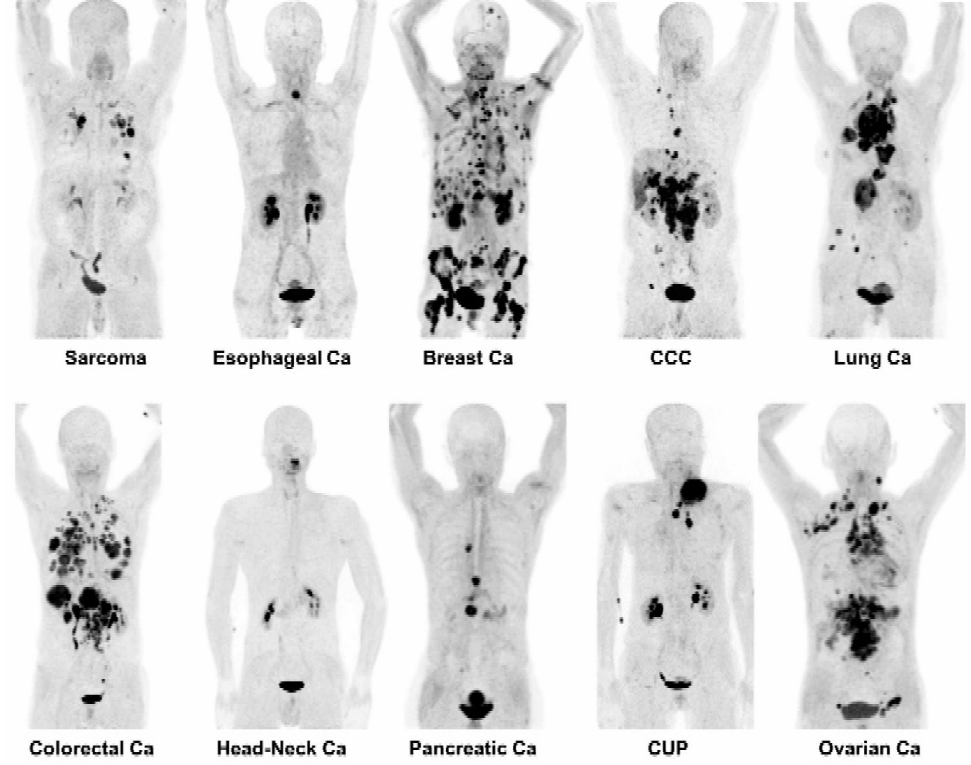
Figure 1. PET imaging with 68 Ga-labeled FAPI-tracers. By targeting the cancer-associated fibroblasts while providing a low uptake in non-target organs and a fast background clearance, the FAPI-tracers allowed the detection of different tumor entities with a high specifity. Picture sections were taken from Kratochwil et al.; copyright Society of Nuclear Medicine & Molecular Imaging